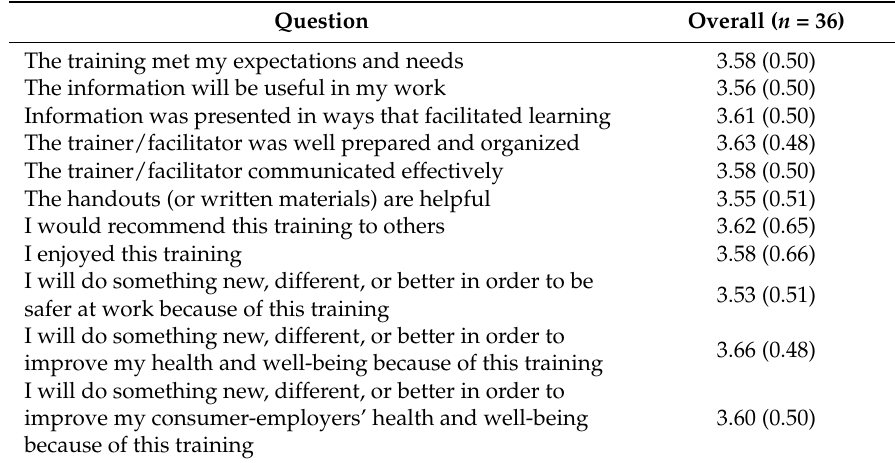
Table 5. Worker evaluations for COMPASS groups in the Oregon Home Care Commission training system: Mean ( SD ) ratings for quantitative questions in the revised/new